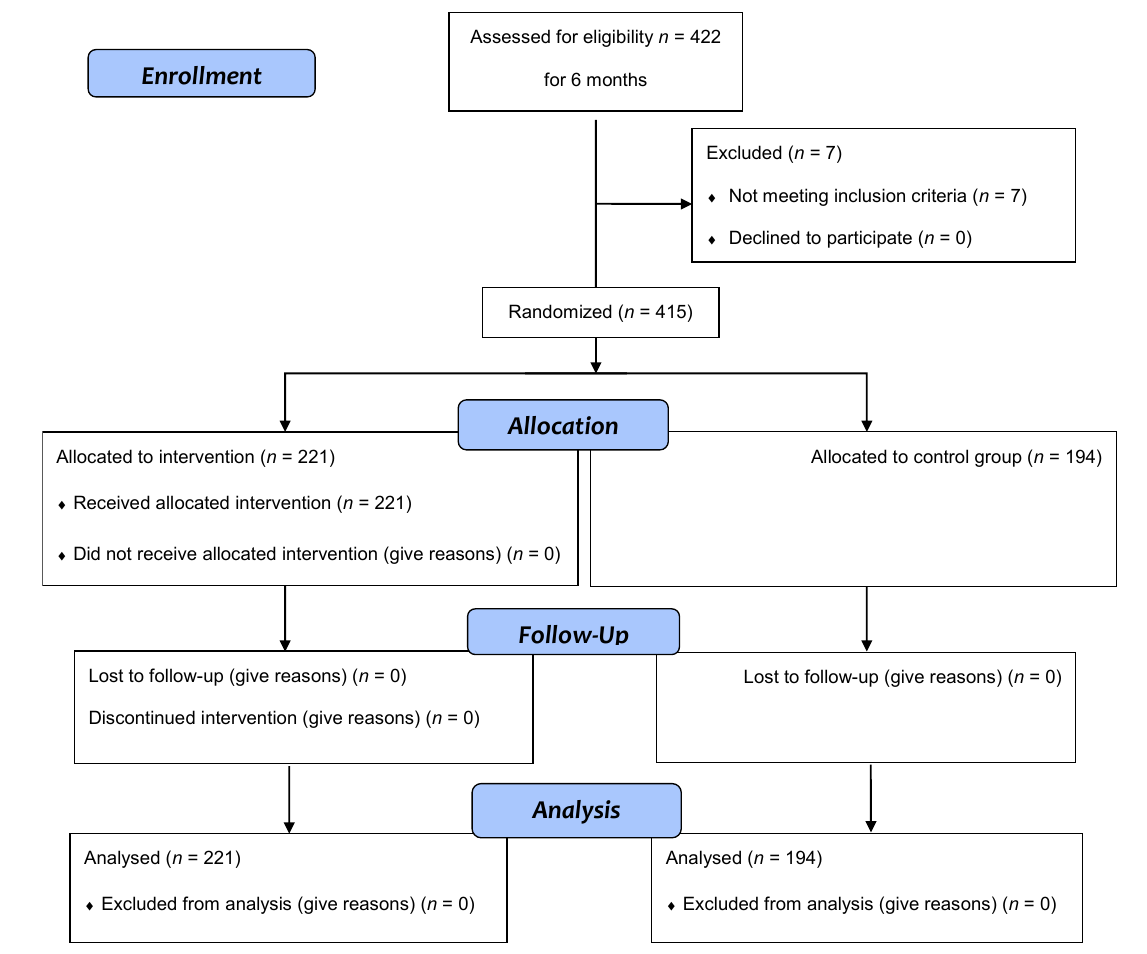
Figure 1. Flowchart of intervention. The intervention group and CG did not differ in sex distribution ( p = 0.579), age